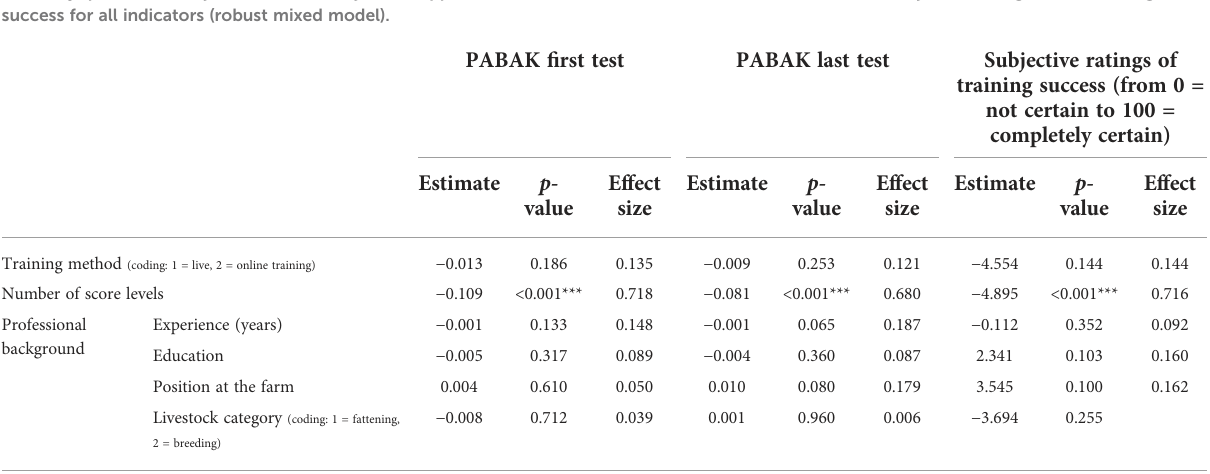
TABLE 4 Effects of the training method, number of score levels, and the professional background, including livestock category on inter-rater reliability (prevalence-adjusted and bias-adjusted kappa, PABAK) in the fi rst and last online tests and on the subjective ratings of the training success for all indicators (robust mixed